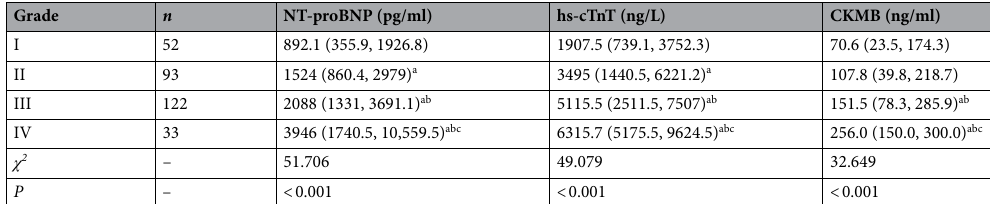
Table 2. Markers of myocardial injury [M (Q25, Q75)]. a vs. Grade I, b vs. Grade II, c vs. Grade III, P < 0.05. NT‑proBNP N-terminal forebrain natriuretic peptide, hs‑cTnT High-sensitivity troponin T, CKMB mb isotype of creatine kinase.